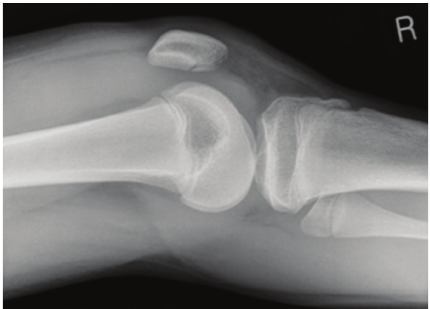
Figure 1: Lateral radiograph of the right knee taken on initial presentation.